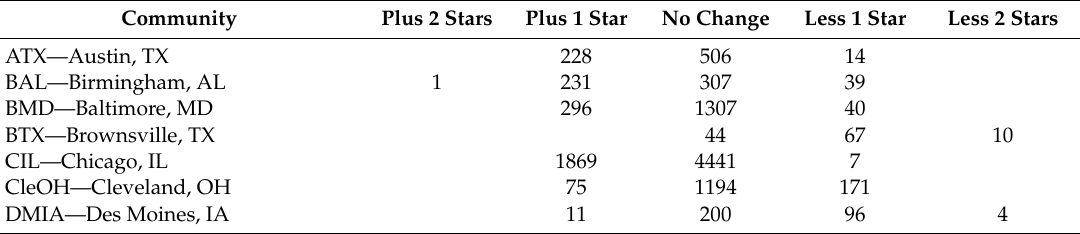
Figure 3. The difference between CEHI AvgW and CEHI IndW for all 22 EnviroAtlas featured communities is shown here. Dark gray dots represent CBGs where CEHI AvgW shows greater positive values than CEHI IndW and a shift towards fewer stars versus light gray dots where CEHI AvgW represents smaller values compared to CEHI IndW and a shift towards more stars. Table 3. Number of CBGs in each community where star rankings increase, remain the same, or decrease when going from CEHI IndW to CEHI AvgW . Community area abbreviations are included in this table to serve as reference throughout the Results Section.